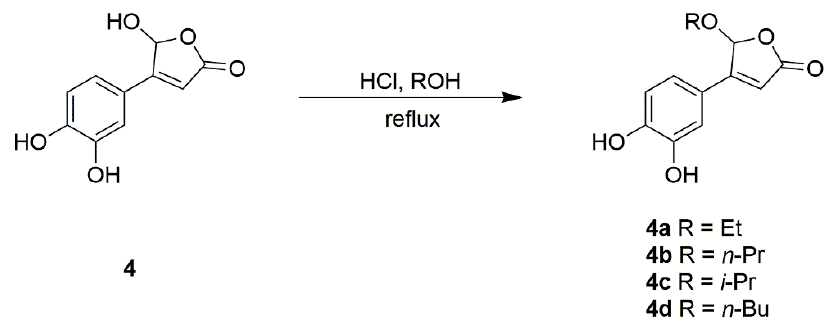
Scheme 1. Synthesis of butenolide derivatives 4a – 4d .